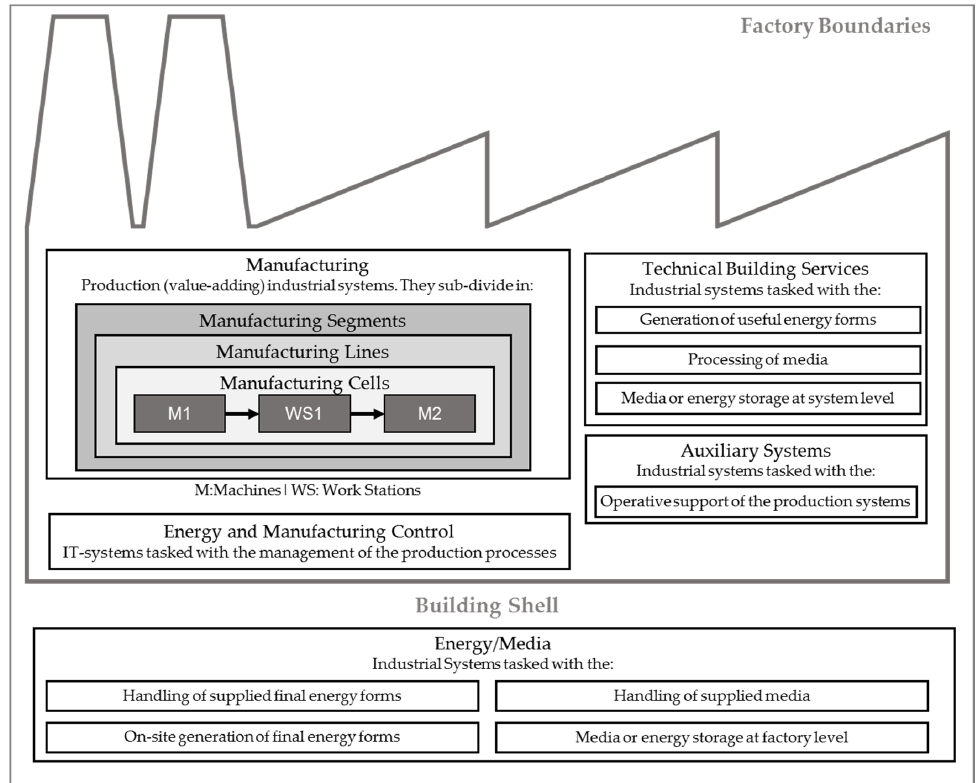
Figure 1. Technical units and sub-units of a factory (Adapted from References [12,14,15], own